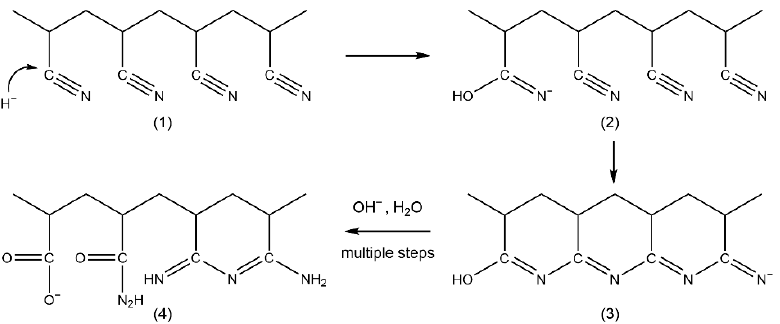
Figure 1. Possible pathway of the cyclized PAN intermediate formation [14]: (1) PAN, (2) nucleophilic substitution of hydroxide ion, (3) cyclized PAN intermediate, (4) functional groups in PAN after hydrolysis.